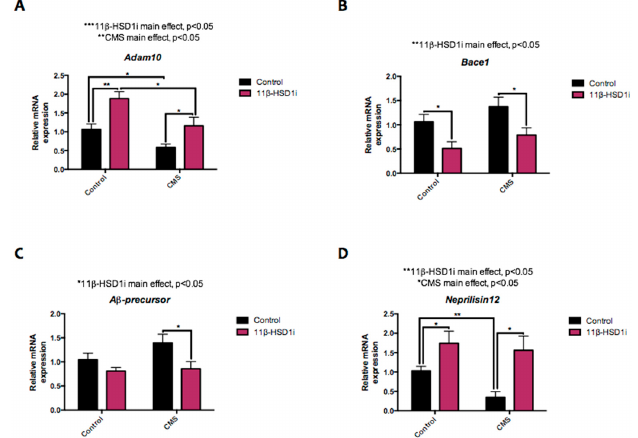
Figure 6. Representative results from APP processing pathways. Relative gene expression of Adam10 ( A ), Bace1 ( B ), A β -precursor ( C ), and Neprilisin12 ( D ). Gene expression levels were determined by real-time PCR. Values are mean ± standard error of the mean (SEM) ( n = 6 for each group). 11 β -HSD1 and CMS main effects as well as interactions were determined. * p < 0.05; ** p < 0.01. 2.7. 11 β -HSD1 Inhibition by RL-118 Changed Synaptic Plasticity Markers after CMS RL-118 increased cAMP response element-binding (Creb) gene expression, although this change was not significant in the CMS group. By contrast, the ratio of pCREB/CREB was reduced after CMS exposure but unmodified after RL-118 treatment (Figure 7A,B). Nevertheless, synaptic markers like postsynaptic density protein 95 (PSD95) and synaptophysin protein levels were increased after 11 β -HSD1 inhibition treatment, both in the control and CMS groups (Figure 7C,D).